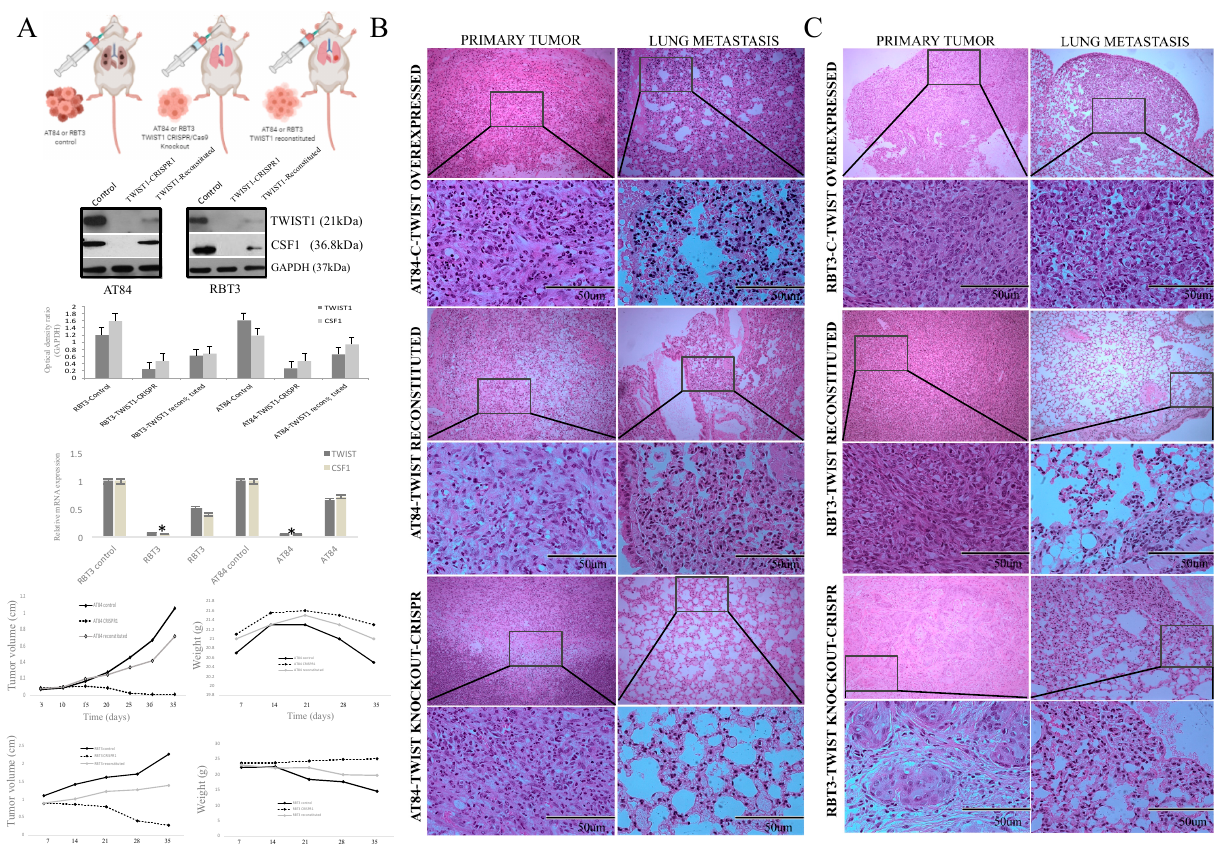
Figure 6. In vivo experiments using murine model (AT84) and a highly metastatic human OSCC (RBT3). ( A ) Immunoblotting and gene expression analysis showing TWIST1 knockout by CRISPR-CAS9 with significant downregulation of CSF1 in AT84 and RBT3. The protein and gene expression of both ( TWIST1 and CSF1 ) are present after TWIST1 be reconstituted in the TWIST1 knockout tumor cells. GAPDH was used as loading control. Tumor volume and weights are illustrated ( n = 8) from animals implanted with AT84 and RBT3 (control, TWIST1 knockout by CRISPR-CAS9, and TWIST1 reconstituted cells) implanted orthotopically in the tongue. * p < 0.005. Representative H&E images using AT84 ( B ) and RBT3 ( C ) cells in the three conditions (control, TWIST1 knockout by CRISPR-CAS9, and TWIST1 reconstituted cells). In both experiments, the animas implanted with modified cells ( TWIST1 knockout by CRISPR-CAS9) showed significant inhibition of distant metastasis, while TWIST1 reconstituted cells increased the metastatic potential. Original magnification: 50 × (top image) and 200 × (bottom